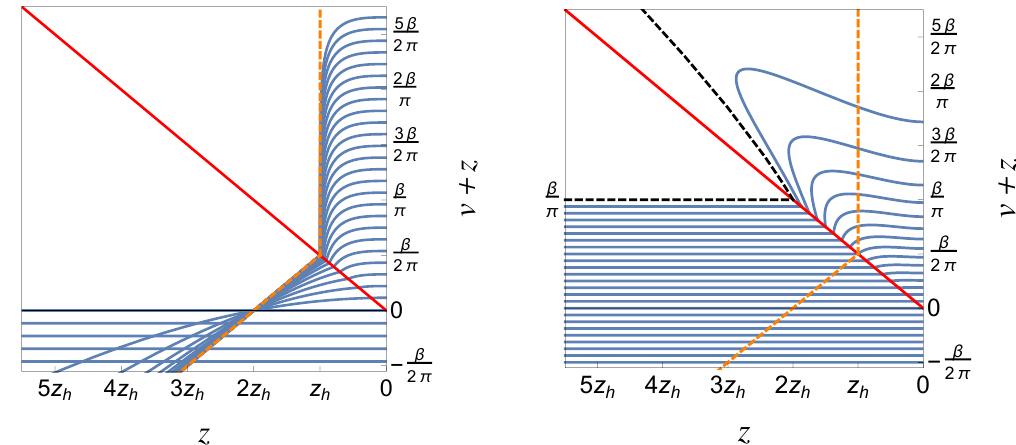
Figure 14 . Left : Fe(cid:11)erman Graham geodesics shot with zero boost angle from the boundary. Note that these geodesics have caustics behind the black hole horizon. Right : extremal geodesics shot with zero boost angle from the RT surface. The black dotted line corresponding to t = (cid:12)=(cid:25) hits the boundary at t = 1 . The orange dotted line is the location of the horizon and the solid red line gives the location of the shockwave. In both cases we plot ( Z ( s ) ; V ( s ) + Z ( s )).